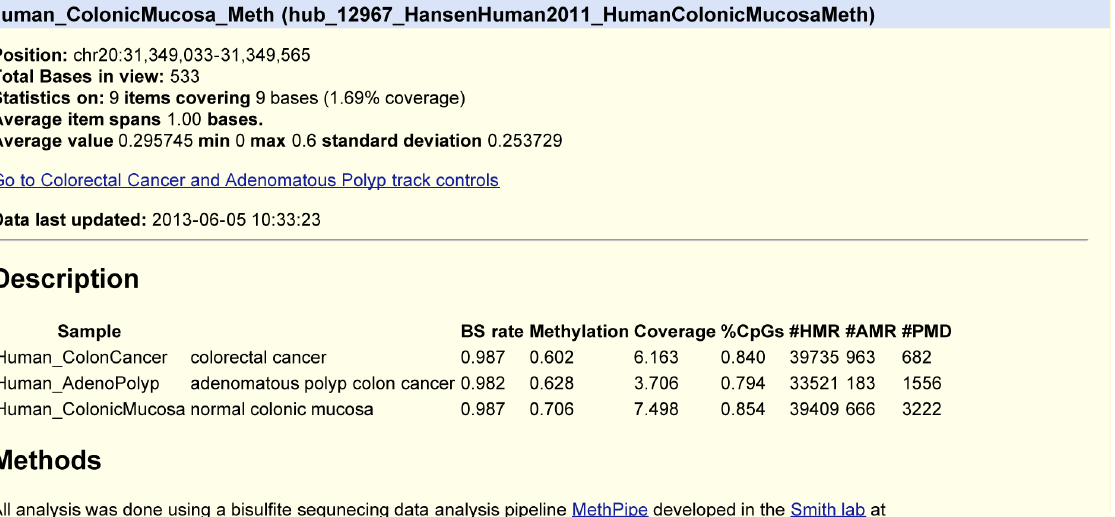
Figure 2. Example of detail meta data and summary statistics of methylation features.